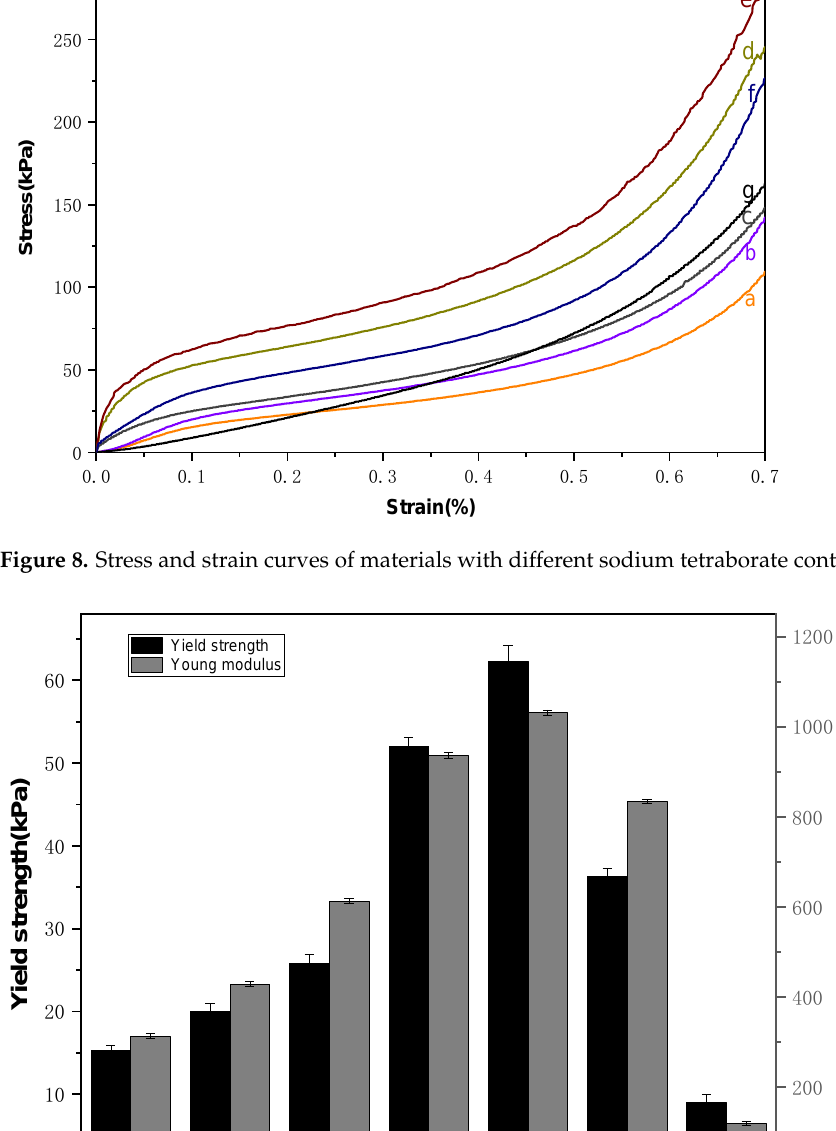
4 5 6 Figure 7. Cushion coefficient of materials as a function of stress, with different PVA contents. 3.2. Effect of Sodium Tetraborate Content on the Mechanical Properties of Materials Samples a–e contain sodium tetraborate contents ranging from low to high, as listed in Table 2. Sample f is high-density polystyrene (HDEPS, with a density of 0.015 g/cm 3 ) and Sample g is low-density polystyrene (LDEPS, with a density of 0.005 g/cm 3 ). As shown in Figure 8, with continuous increases in sodium tetraborate content the stress-strain level